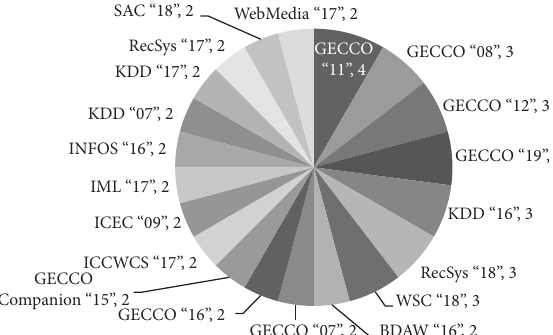
Figure 5: Proceeding names with the number of papers.